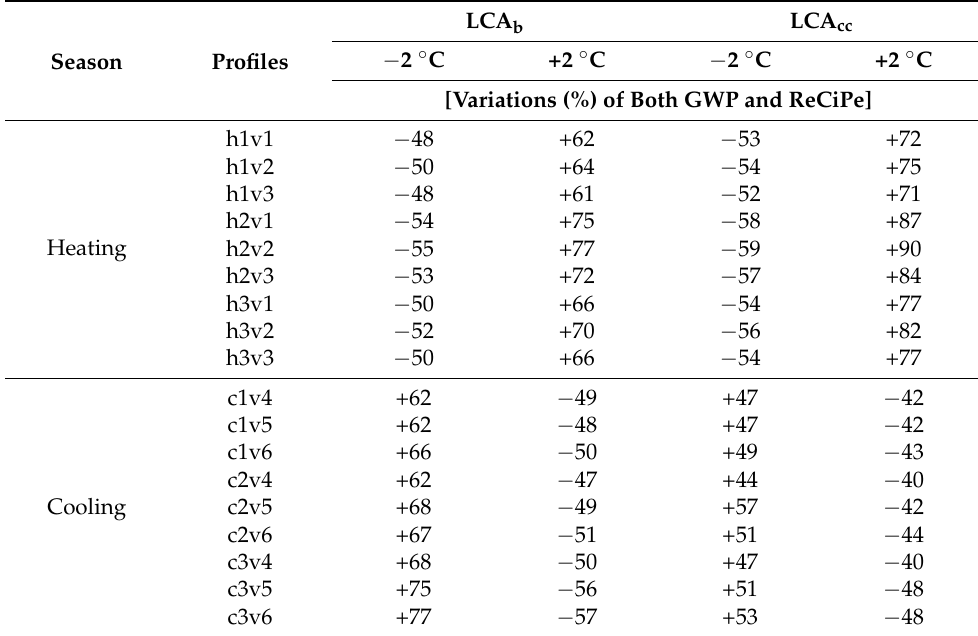
Table 12. Impact variations by varying the setpoint temperatures of ± 2 ◦